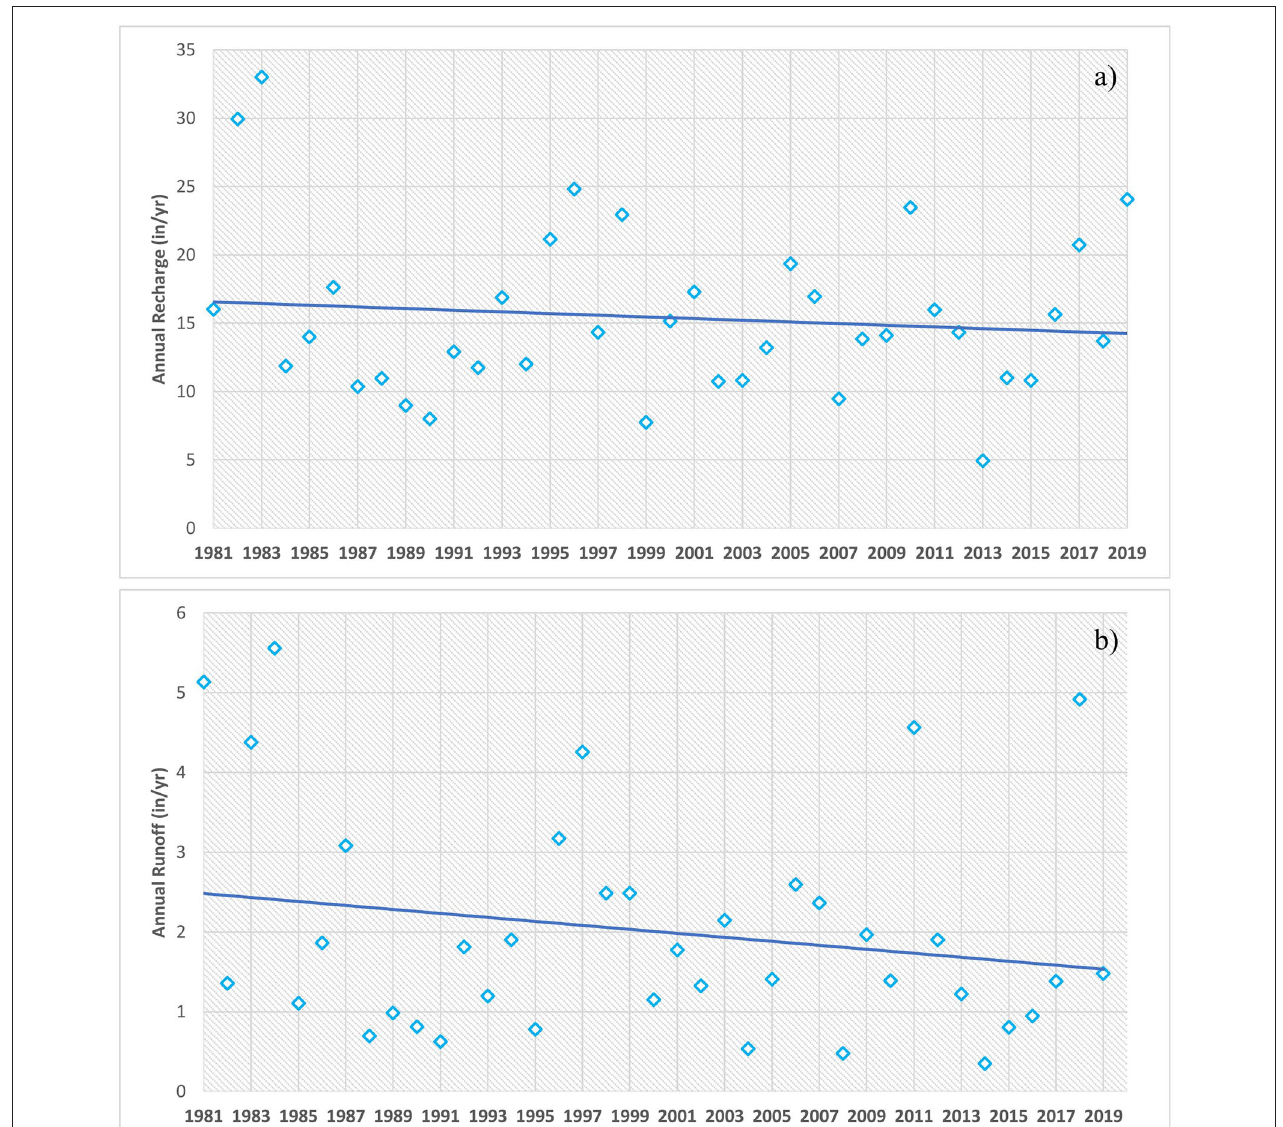
FIGURE 8 | Linear regression plots of (a) SWB recharge and (b) runoff time series during study